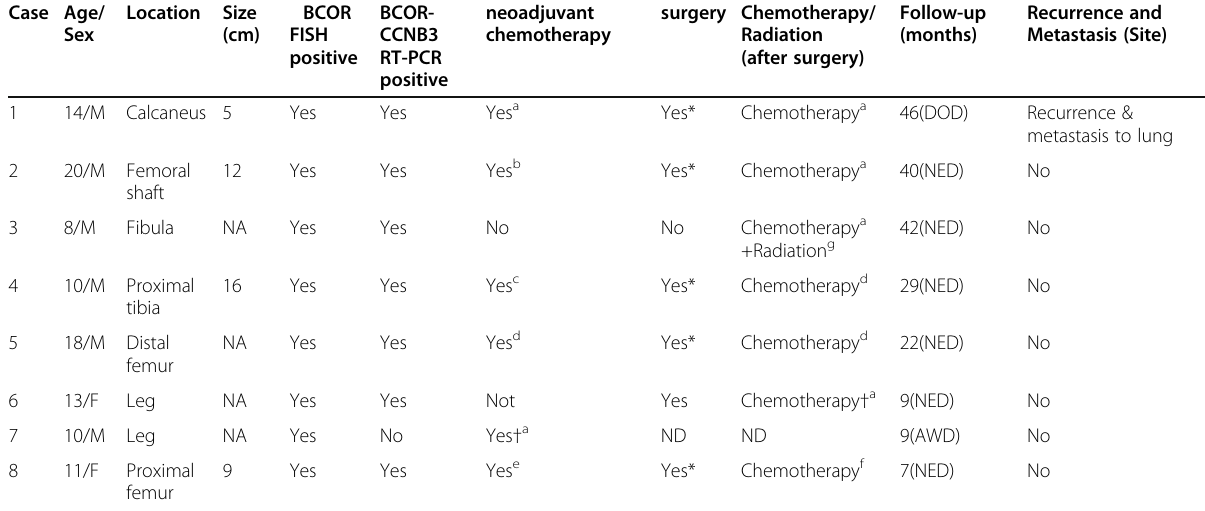
Table 1 Clinicopathologic factors in BCS